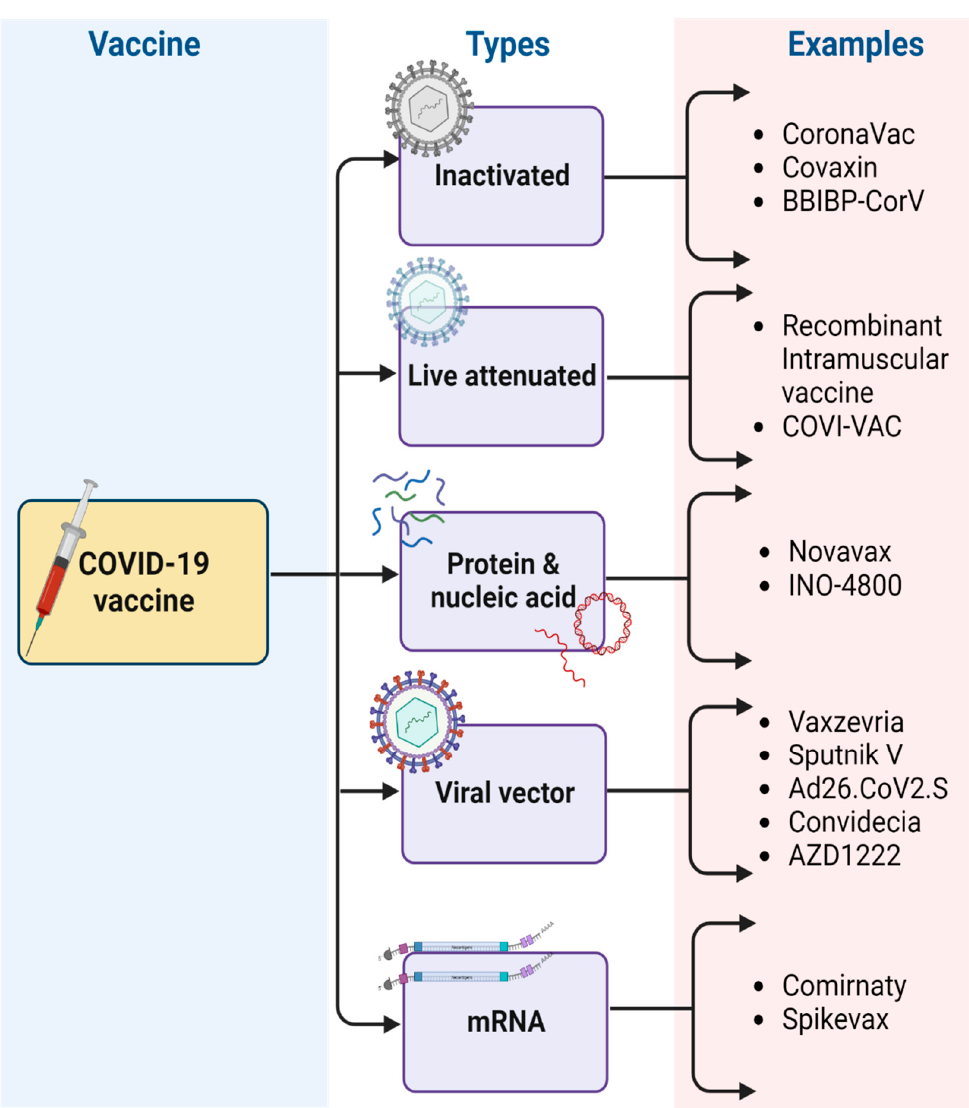
Figure 1. Different types of vaccine for COVID-19 infection. (Created with BioRender.com accessed on 31 December 2022).